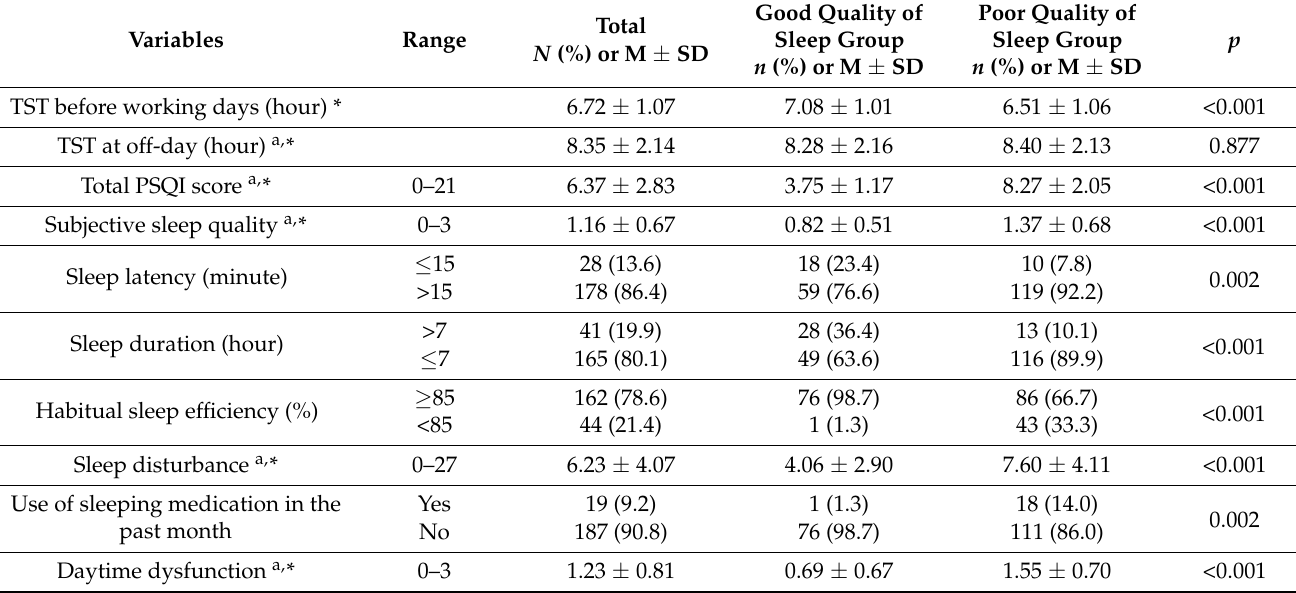
Table 2. Differences of sleep parameter between the two sleep quality groups ( N = 206).